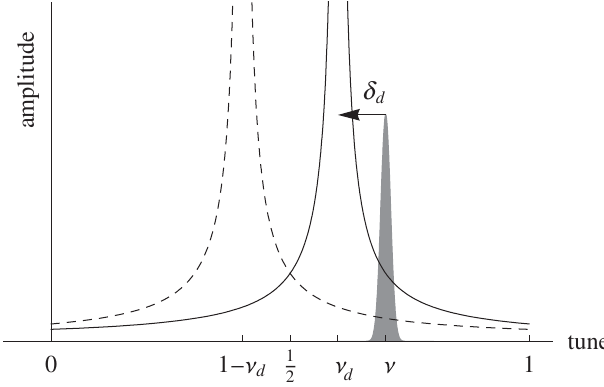
FIG. 2. The amplitudes of the two modes driven by an AC dipole. A circulating beam is driven by the two driving terms of an AC dipole whose driving tunes are (cid:2) d and 1 (cid:1) (cid:2) d . Solid and dashed curves represent the amplitudes of the two modes excited by these two driving terms for a given machine tune. When the machine tune is (cid:2) , beam motion is dominated by the mode of (cid:2) d (solid curve). However, the mode of 1 (cid:1) (cid:2) d (dashed curve) cannot always be ignored since realizable (cid:3) d ¼ (cid:2) d (cid:1) (cid:2) is lim- ited by the tune spread of the beam (shaded